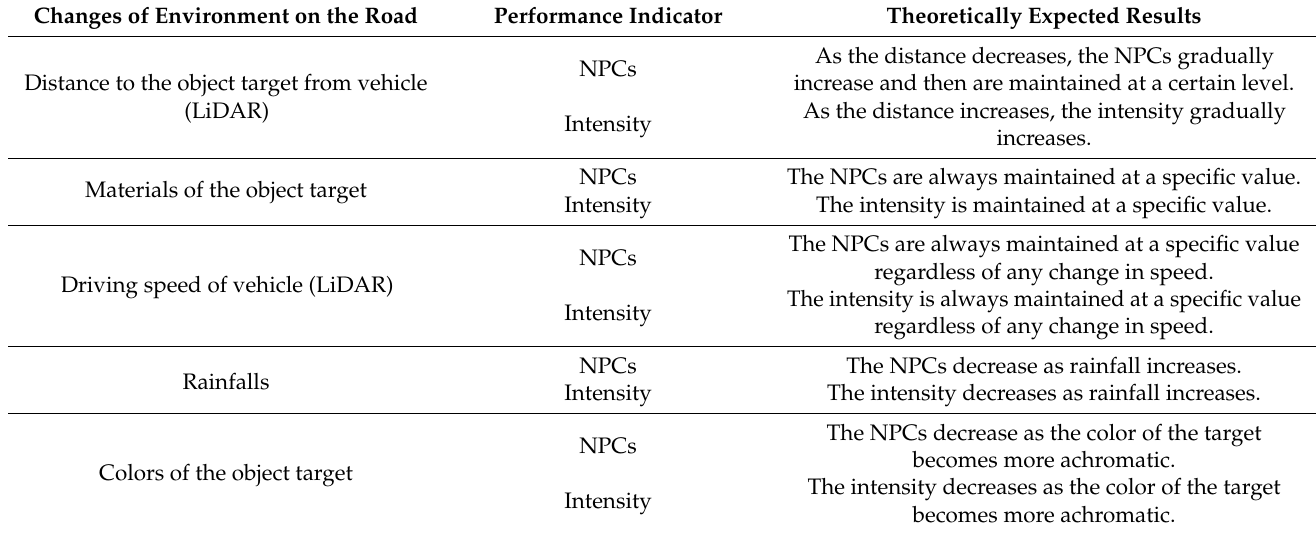
Table 1. Test items used in the study for performance verification of